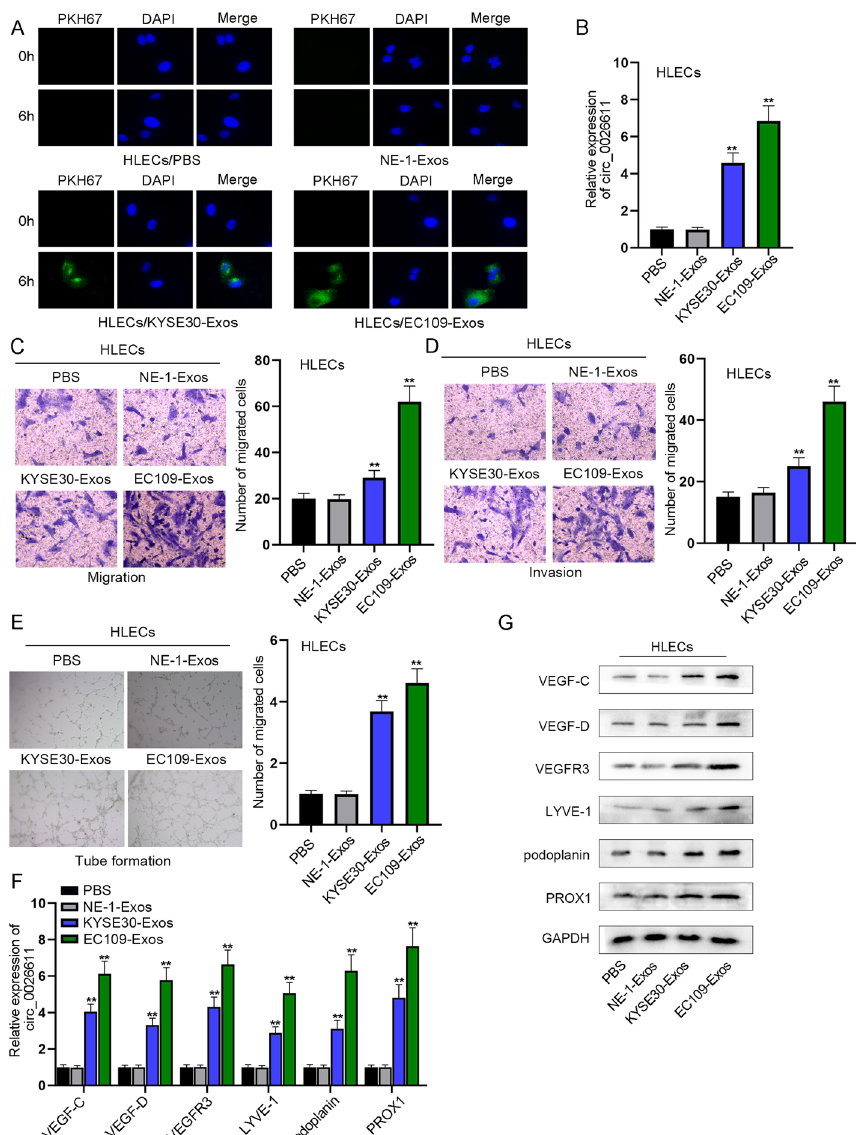
Fig. 2 ESCC cell-derived exosomes promoted the migration, invasion, and lymphangiogenesis of HLECs. A Exosome labeling and tracking assay detected the absorption of exosomes from ESCC in HLECs. B circ_0026611 expression change after HELCs absorbing ESCC-derived exosomes was tested. C , D Transwell assays were conducted to determine the influence of treating ESCC-derived exosomes on HLEC migration and invasion. E Whether ESCC-derived exosomes may affect HLEC tube formation was verified by tube formation assay. F , G Expression of the lymphangiogenesis-related markers in HLECs was tested in different groups. ** P <